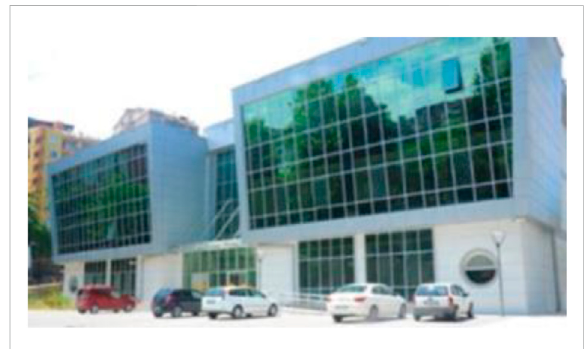
General view of a library building (Zonguldak Bulent Ecevit University,